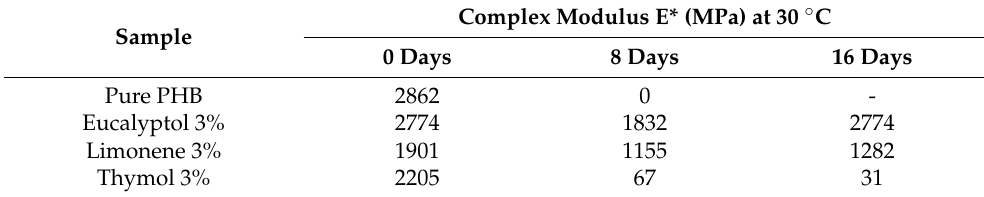
Table 2. DMA: Complex modulus E* for PHB mixtures at 30 ◦ C.